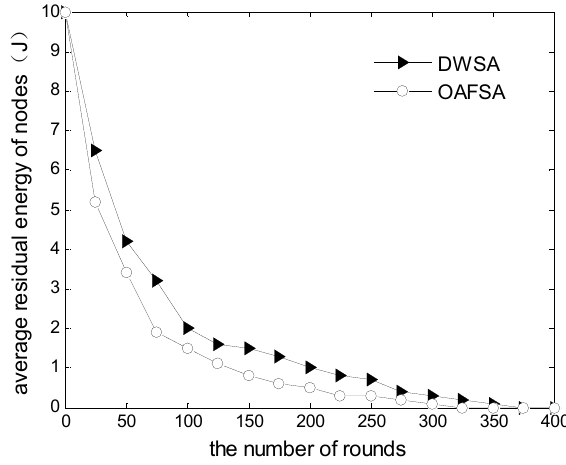
Figure 10. Comparison of average residual energy of nodes at varying numbers of nodes.